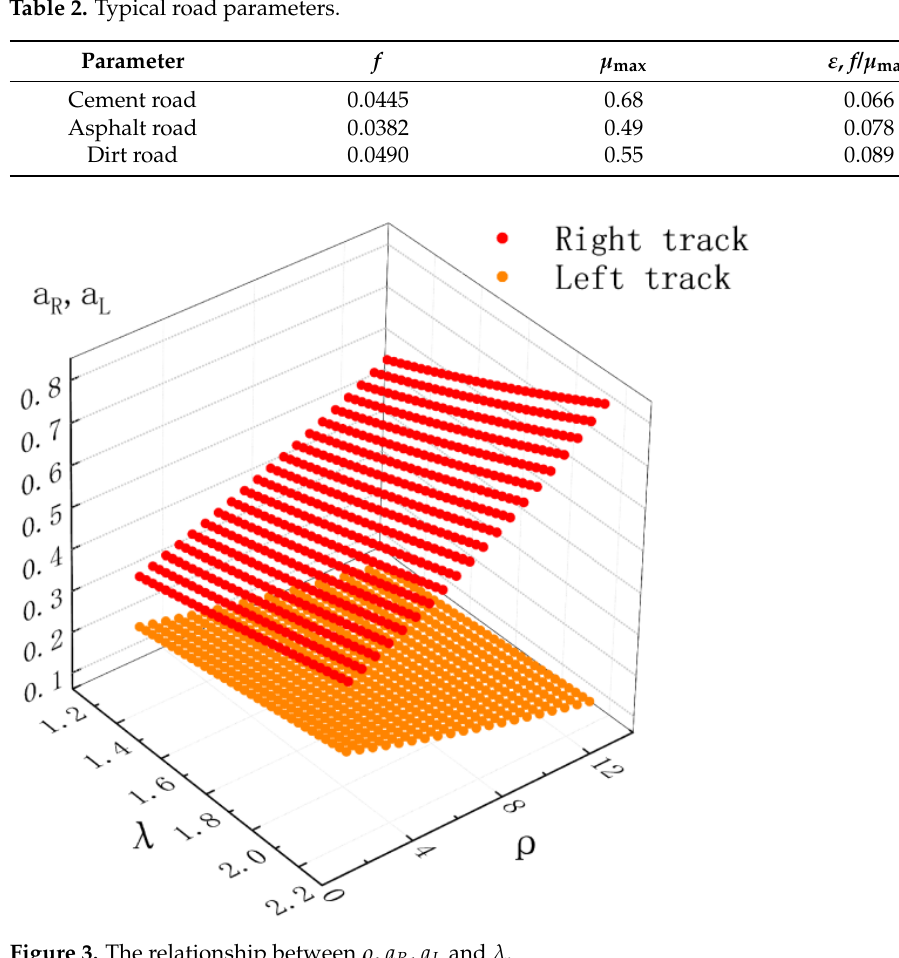
Figure 3. The relationship between